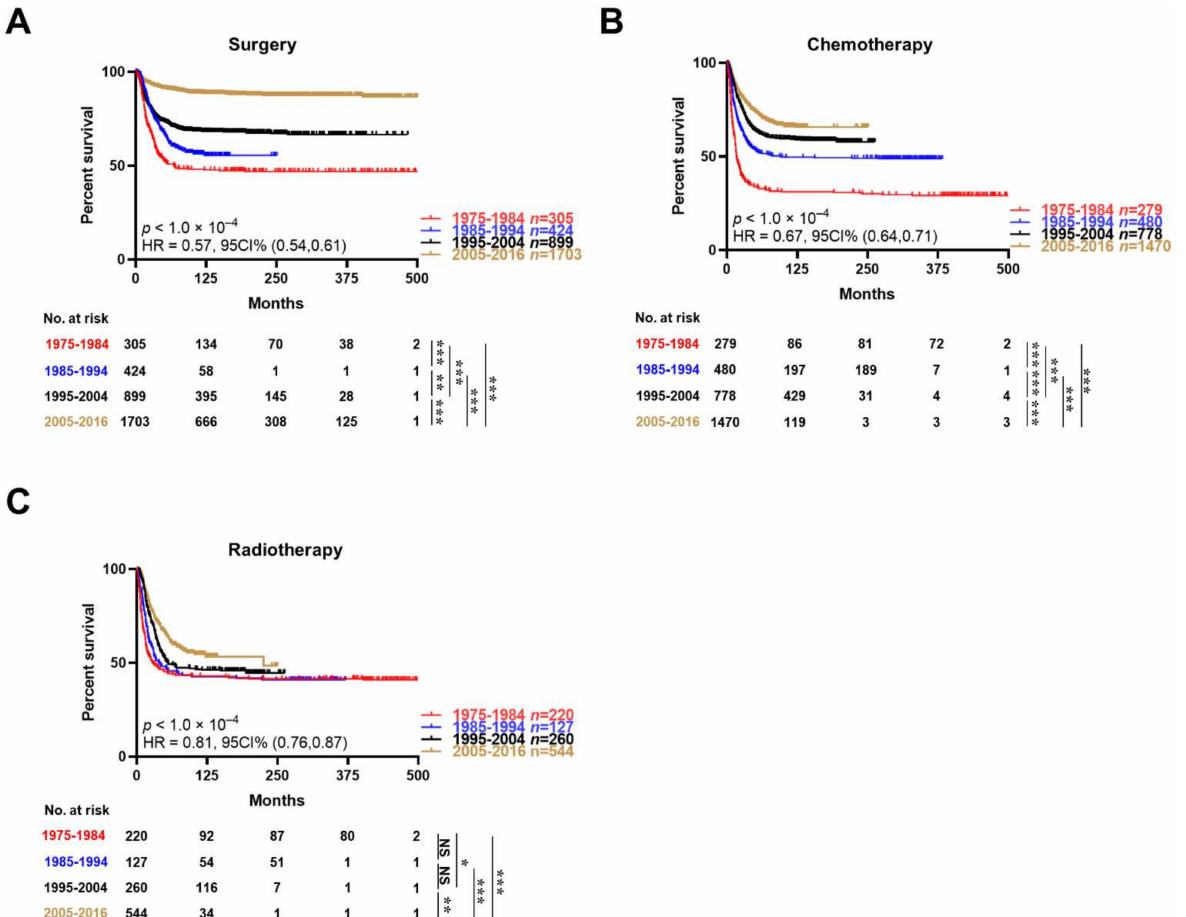
Figure 4. Trend of the conventional treatment results with the advancement of time in unmatched data. ( A ): Patients receiving surgery; ( B ) Patients receiving chemotherapy; ( C ): Patients receiving radiotherapy. Kaplan–Meier curves reflecting the disease-specific survival of patients who underwent the indicated treatment. Log-rank test for survival comparison in ( A – C ). * p < 0.05, ** p < 0.01, *** p < 0.001. NS,